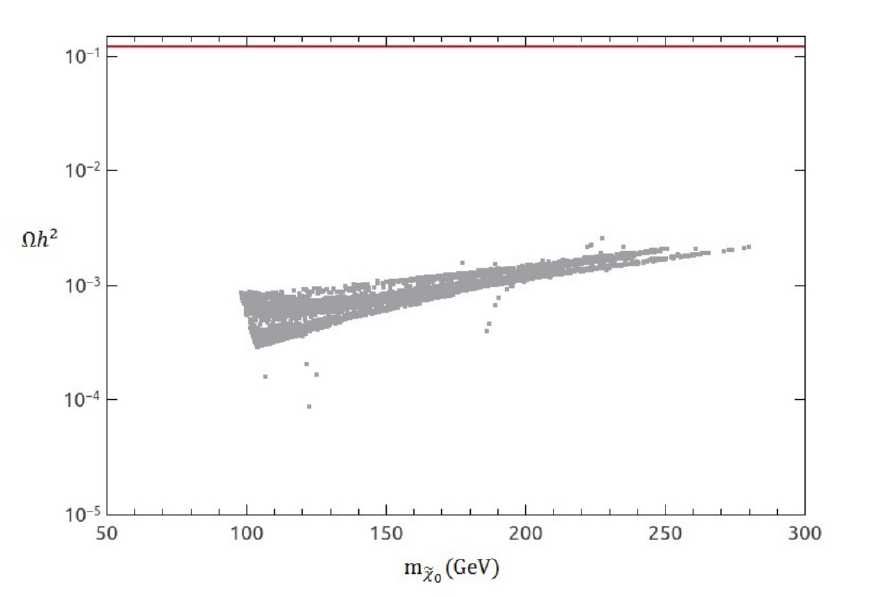
Figure 7 . The DM relic density versus the DM mass. All points can also satisfy the spin- independent DM direct detection constraints by LUX2016 and